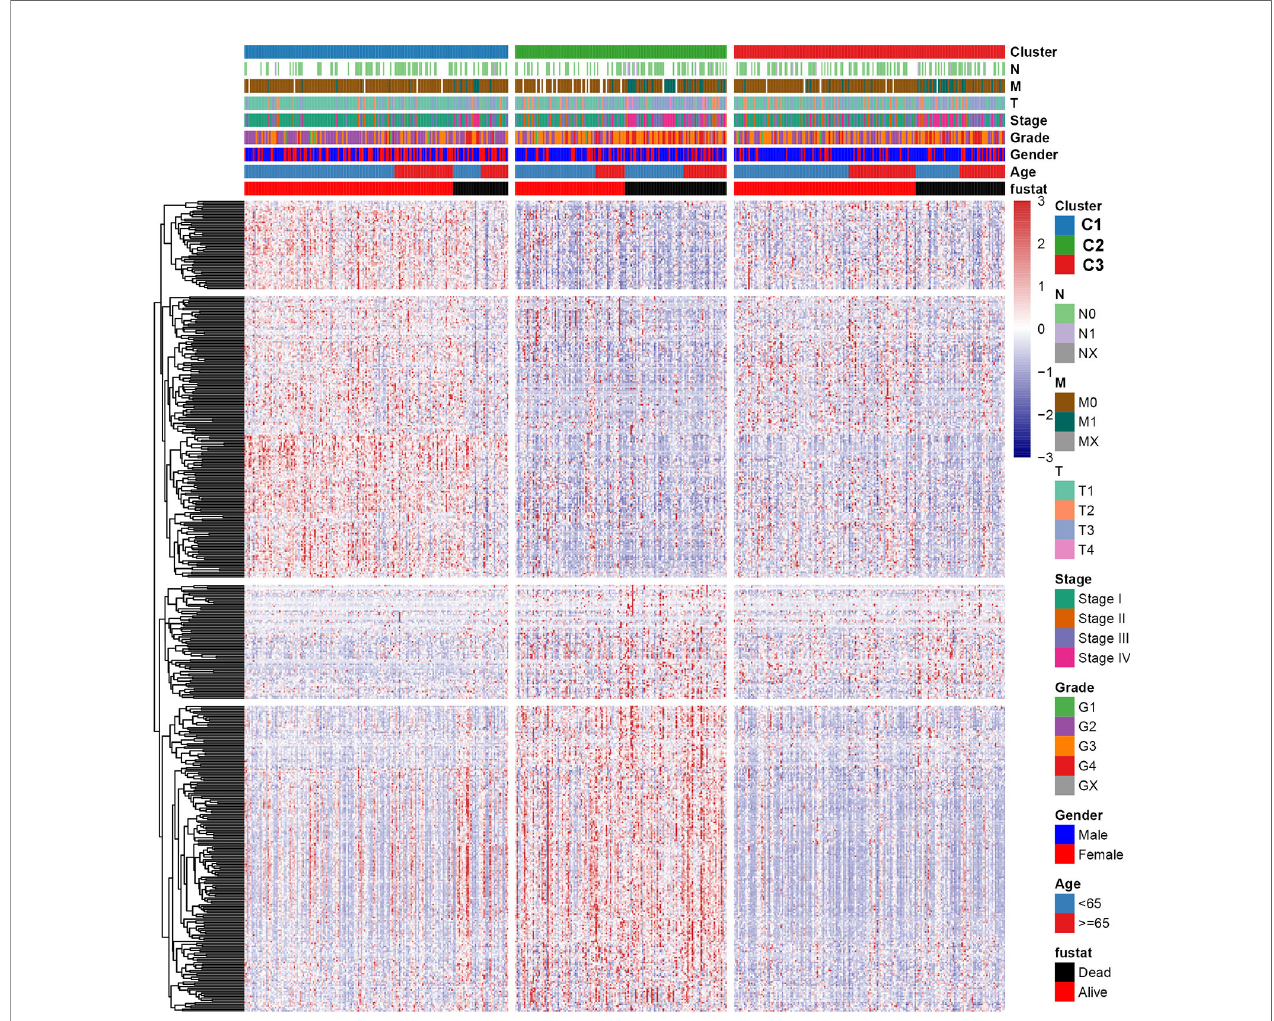
FIGURE 10 | A heatmap was shown for the relationship between clinical factors, subtype and EMT-related lncRNA expression in the TCGA